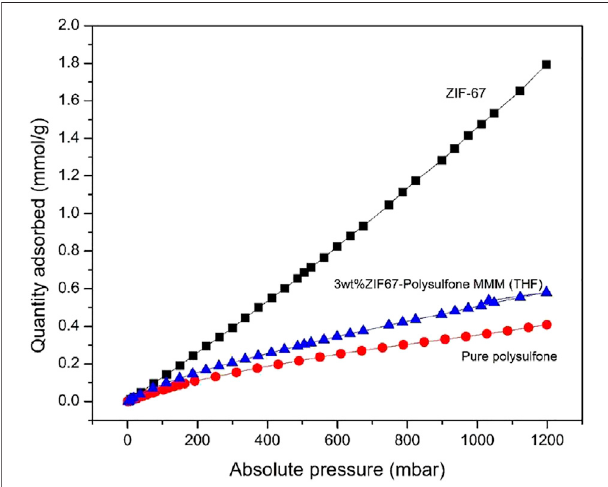
FIGURE 6 | Gas adsorption isotherm of pure polysulfone (Red), ZIF-67 (black), and ZIF-67 MMM (blue) at 273 K.